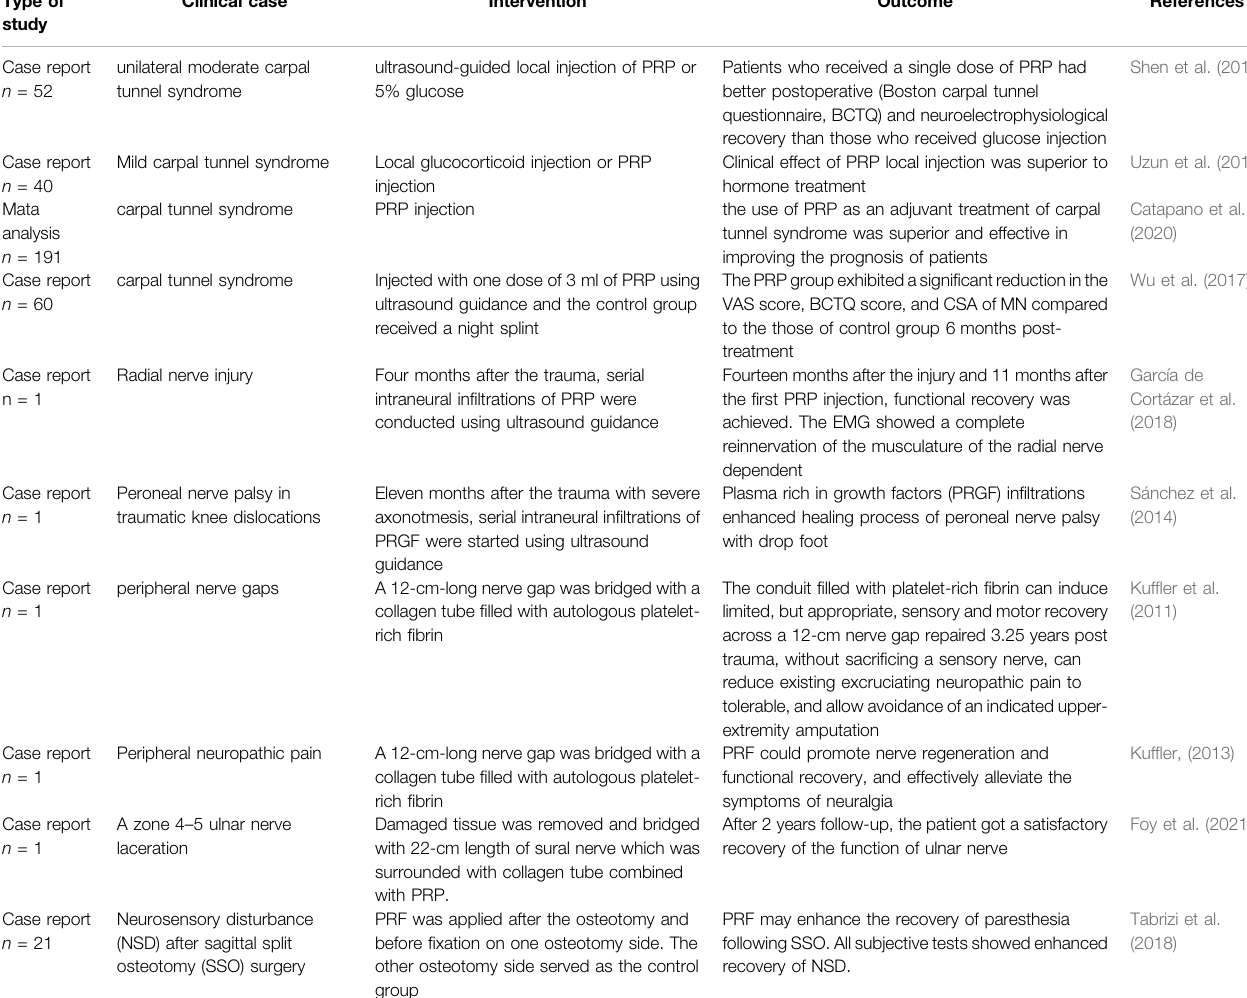
TABLE 5 | Summary of clinical application of PRP on peripheral nerve